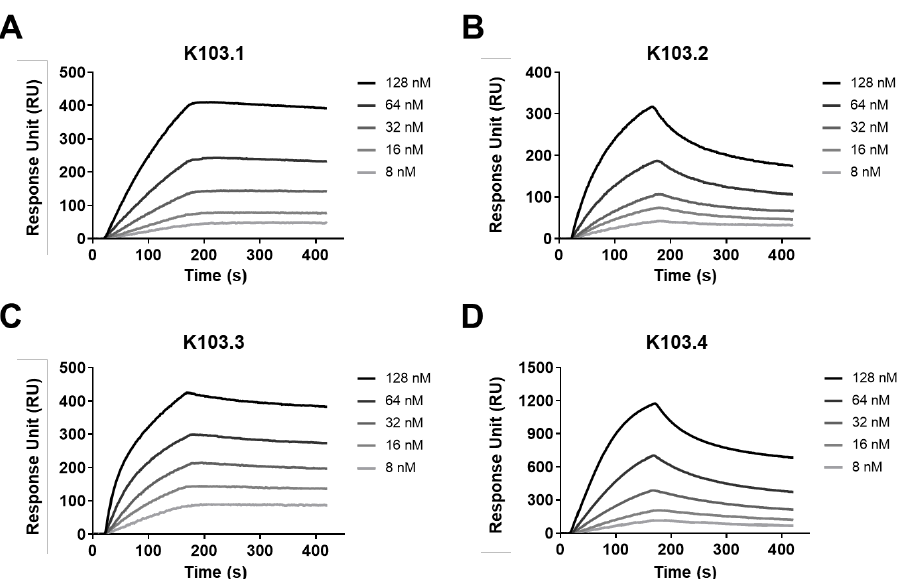
Figure 4. Kinetic analysis of the interaction between the selected scFv-Fc antibodies and MF-hCADM1. The binding affinities of the selected antibodies to MF-hCADM1 were measured using SPR. Each SPR sensorgram shows the interaction of the different concentrations (8, 16, 32, 64, and 128 nM) of ( A ) K103.1, ( B ) K103.2, ( C ) K103.3, and ( D ) K103.4 to an MF-hCADM1-BSA-immobilized sensor chip.